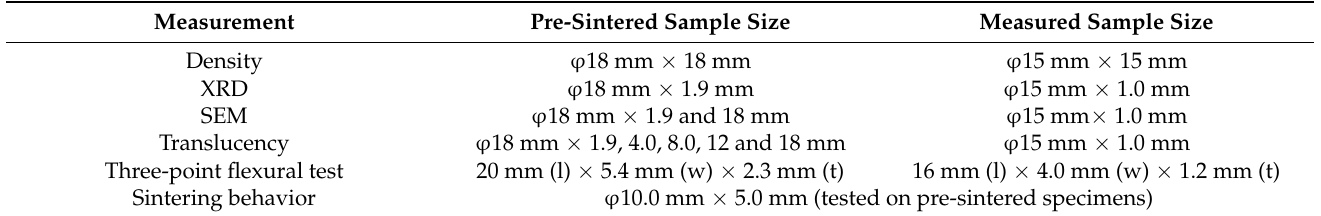
Table 2. Specimen dimensions in each test.